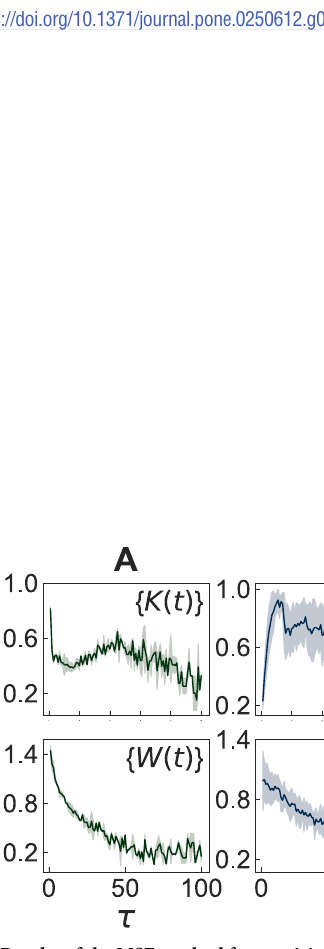
Fig 4. Results of the MSE method for empirical datasets. Results of the MSE method applied to time series { K ( t )} (top panels) and { W ( t )} (bottom panels), respectively denoted as S K and S W , of six face-to-face interaction datasets: (A) primary school, (B) hospital, (C) workplace, (D) school (2011), (E) school (2012), and (F) conference. E E See the main text for